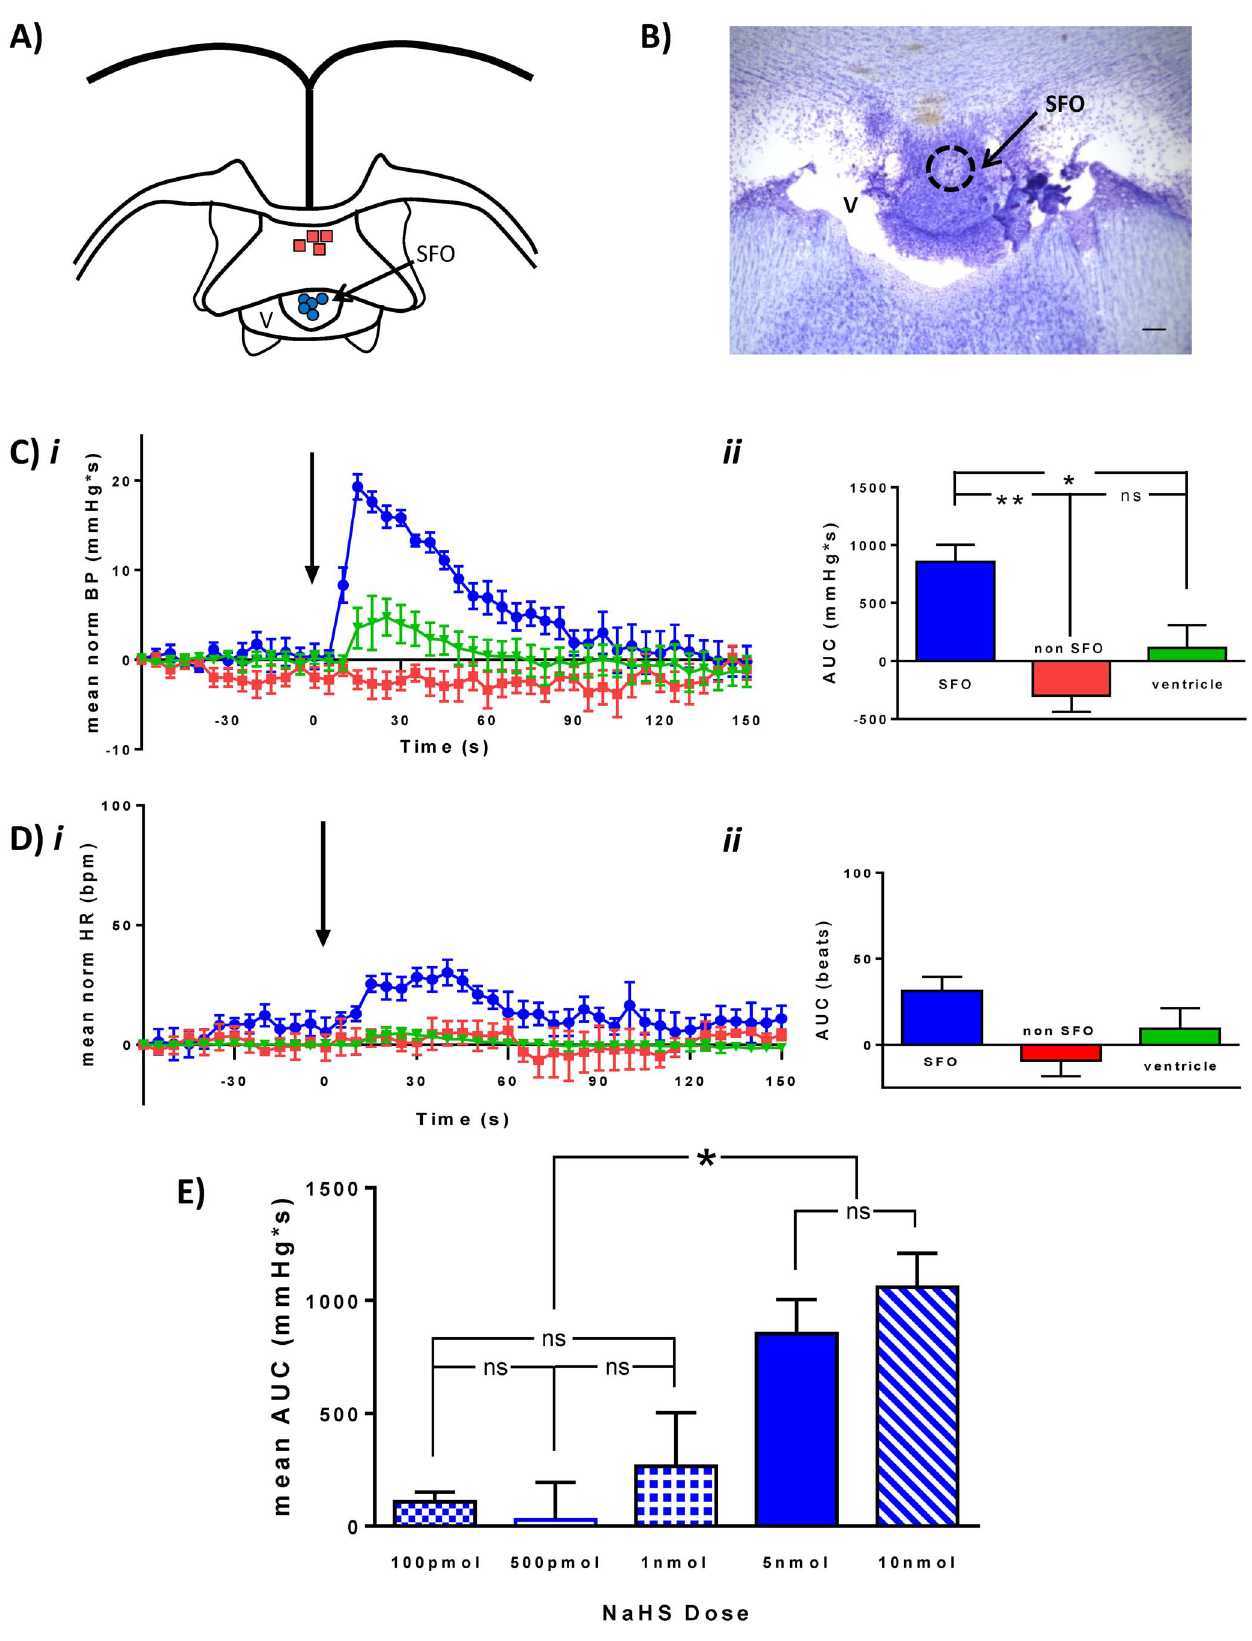
Figure 2. Hydrogen sulfide microinjection into the SFO increases BP. Individual microinjection locations in SFO (Blue circle) and non-SFO sites (red squares) are illustrated in the schematic (A). The photomicrograph (B) shows one of the SFO microinjection sites (scale bar: 100 m m) C)